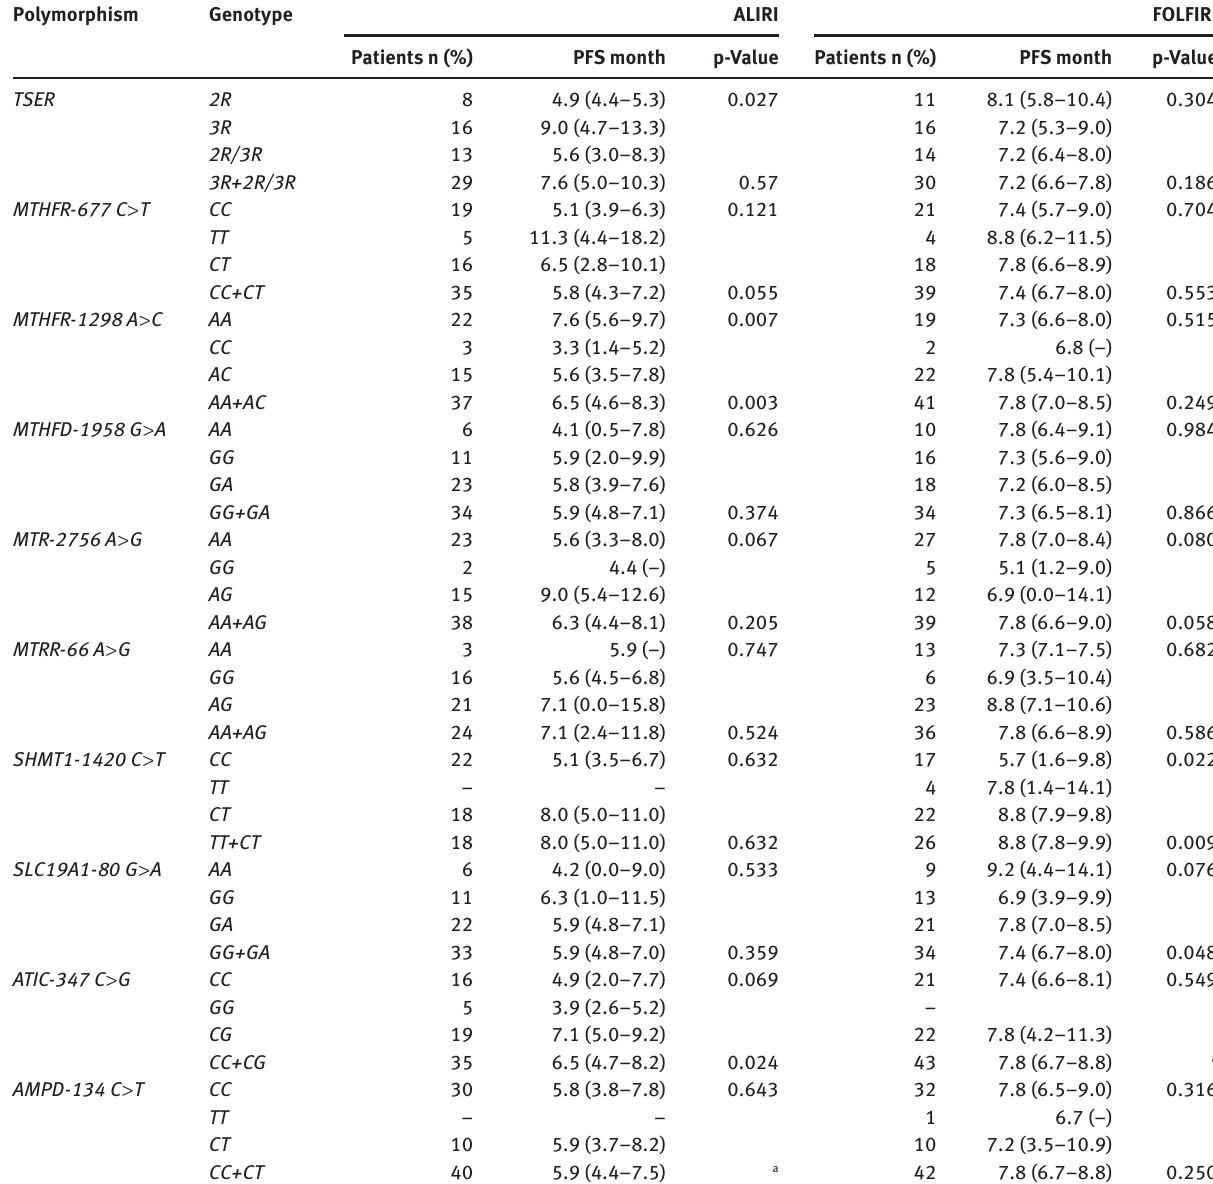
Table 2 Polymorphisms impact on PFS according to